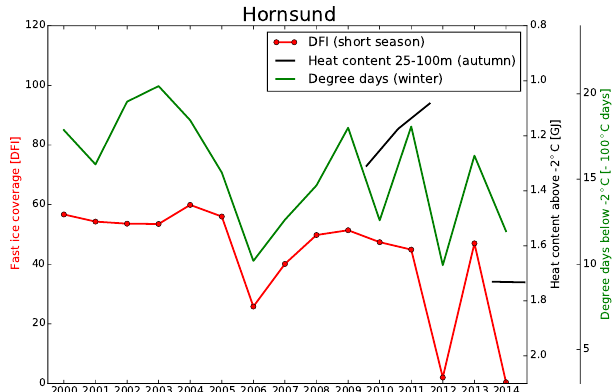
Figure 9. Hornsund’s (red) “days of fast ice” (DFI) values of the short season, compared to (black) autumn heat content above -2 ◦ C of the 25–100m depth water column and (green) winter negative degree days below -2 ◦ C. Heat content values are calculated using the mean temperature profile inside Hornsund during autumn (July– September). Negative degree days have been derived from temper- ature measurements at the Hornsund station at 77.00 ◦ N, 15.54 ◦ E. Note the reversed heat content